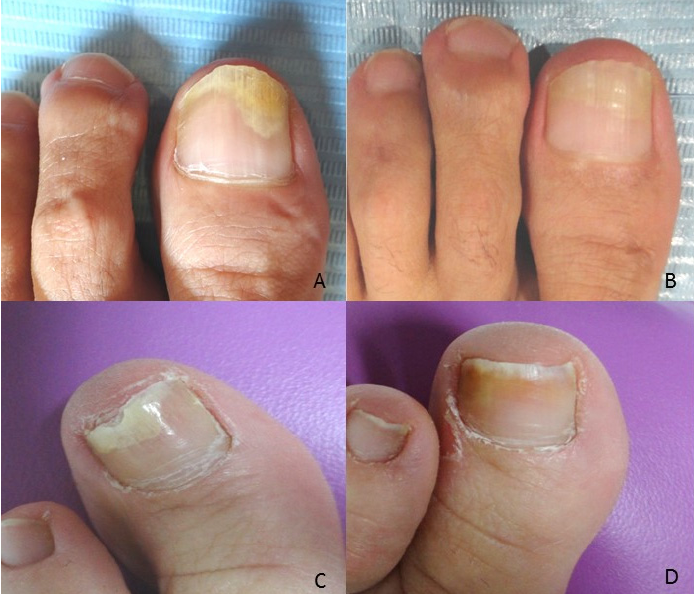
Figure 2. Same patient before and after treatment ( A , B ). Clinical improvement is observed, with a reduction in the affected area of the longitudinal axis from 68.57% to 20.00%. Another patient before and after treatment ( C , D ), showing clinically meaningful changes with a reduction in the affected area of the longitudinal axis from 41.94% to 28%.